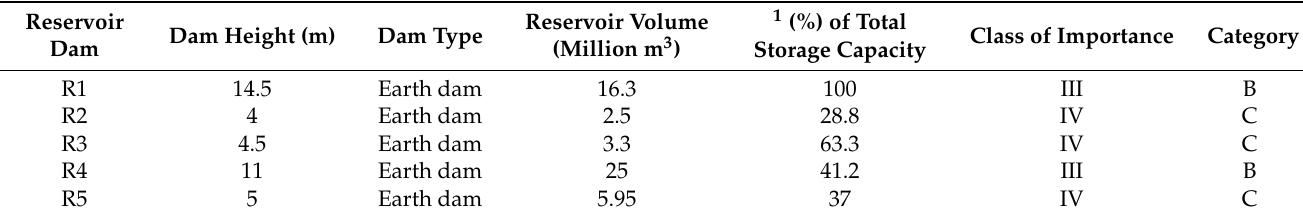
eu river basin according to Romanian National Classification (RNC) [51]. ,